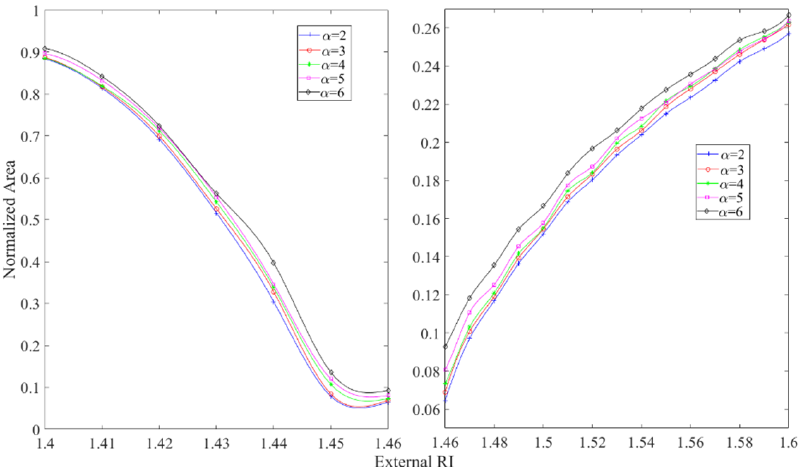
Figure 11. Correlation curves of the mean points for several α values.